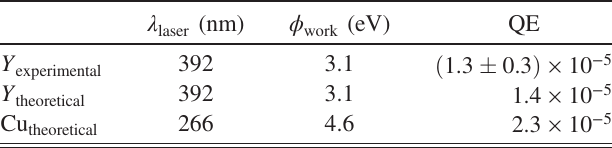
TABLE III. Comparison of Yan Cu theoretical QE value [42] at the same experimental condition reported in Table